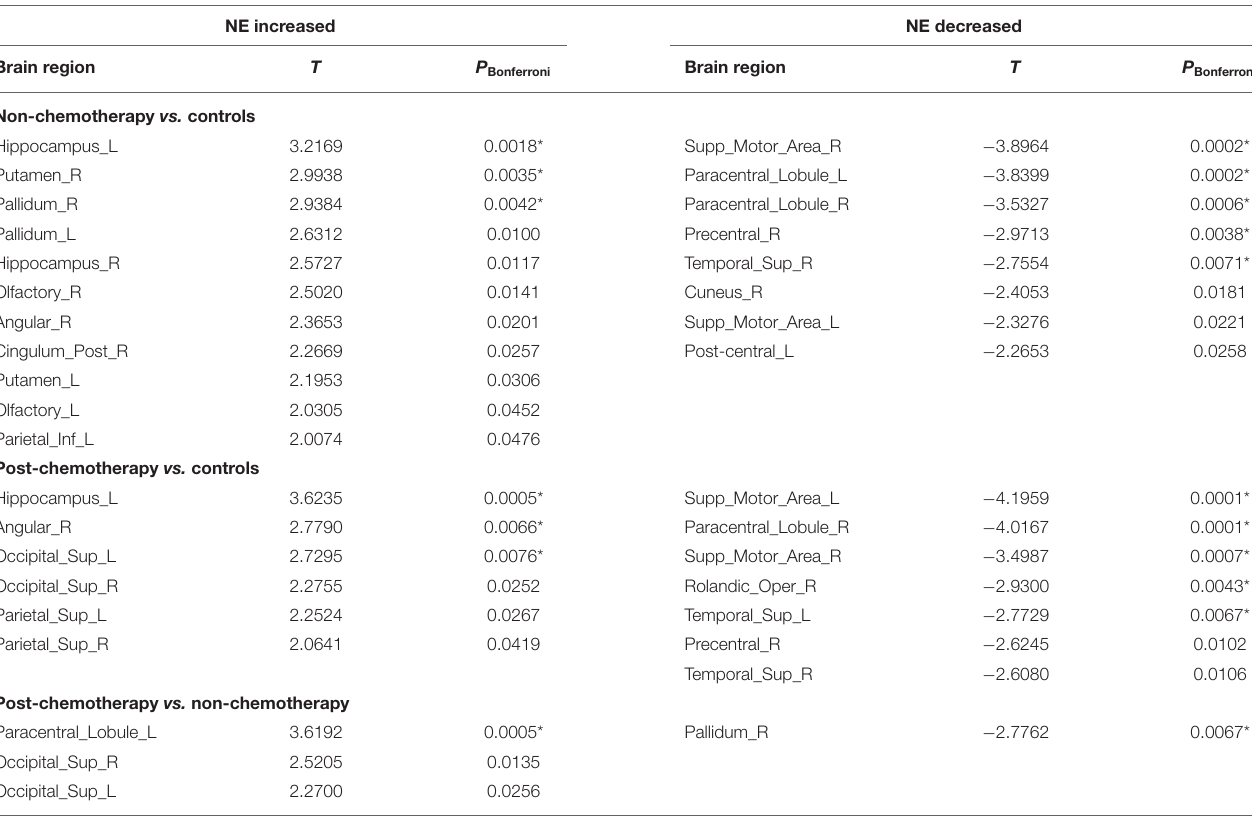
TABLE 3 | Regions showing increased nodal efficiency (NE) and decreased NE in non-chemotherapy compared with controls, post-chemotherapy compared with controls, and post-chemotherapy compared with non-chemotherapy. NE increased NE decreased Brain